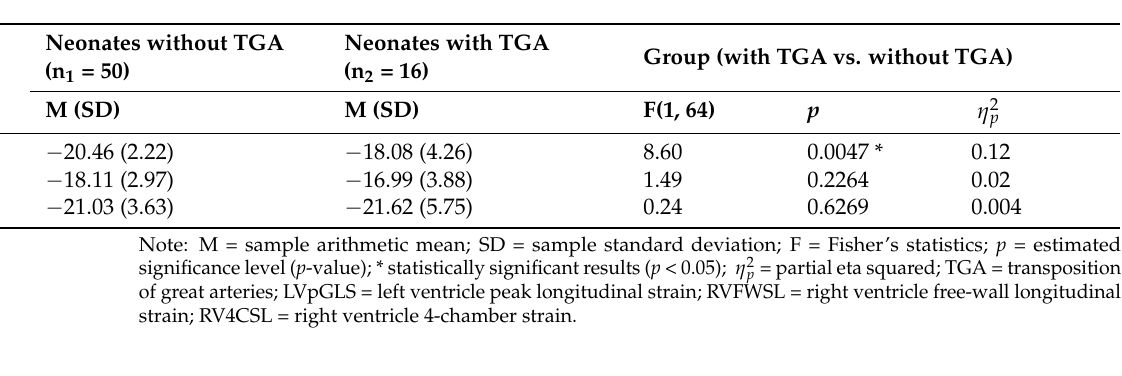
Table 3. One-way analysis of variance (ANOVA) with group (neonates with TGA vs. neonates with- out TGA) as between-subject factor performed on the left- and right-ventricle-related longitudinal strain variables.